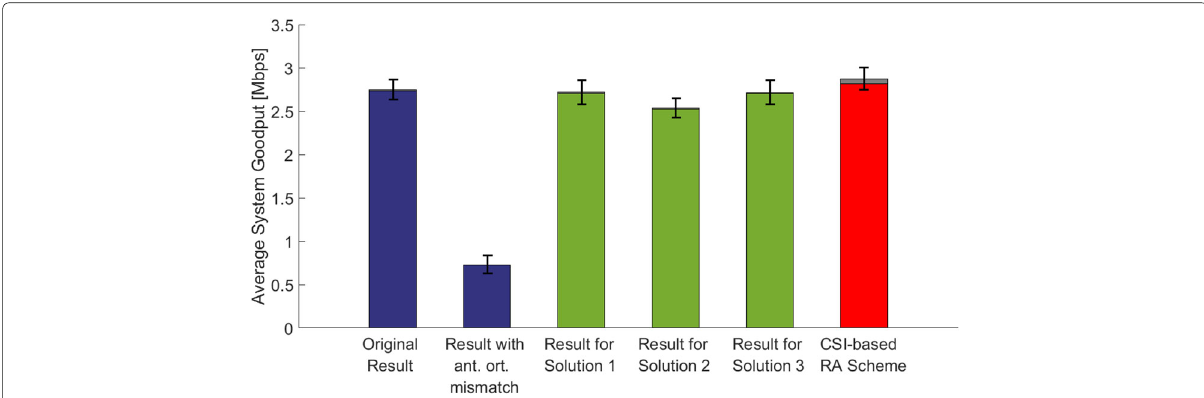
Fig. 9 Effect of misalignment in terminal antenna orientation on the average system goodput and its mitigation results